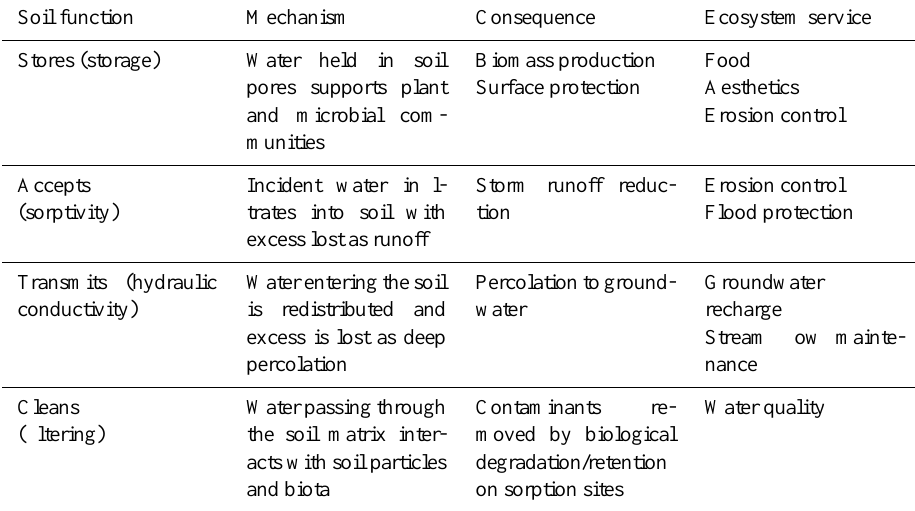
Table 3. Soil functions related to the water cycle and ecosystem